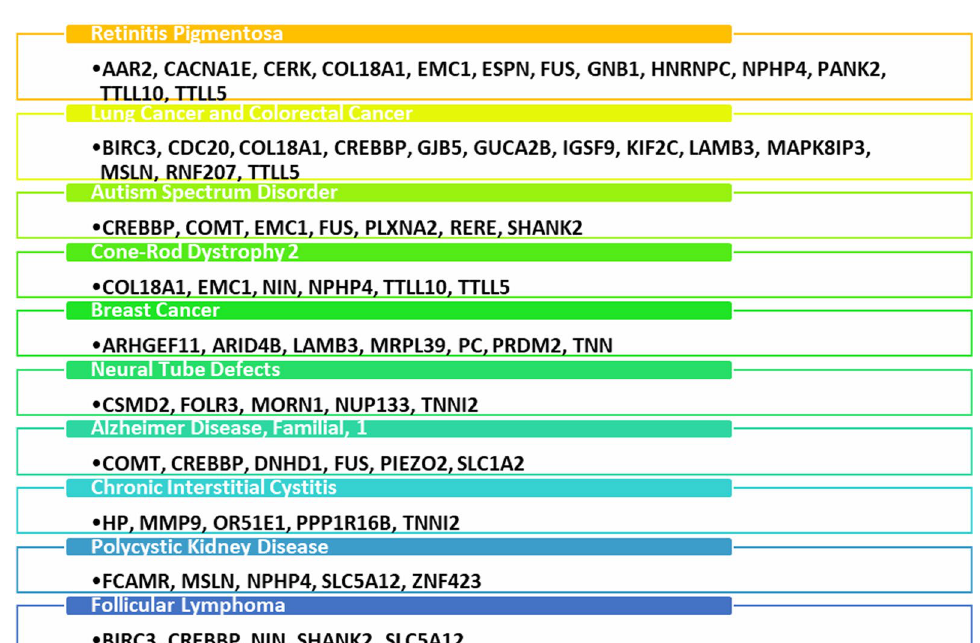
Fig. 6 Top 10 most common diseases associated with the genes of mural and cumulus granulosa cells. According to MalaCards and GeneAnalytics, these are the top 10 most prevalent diseases that are connected with the genes found in mural and cumulus granulosa